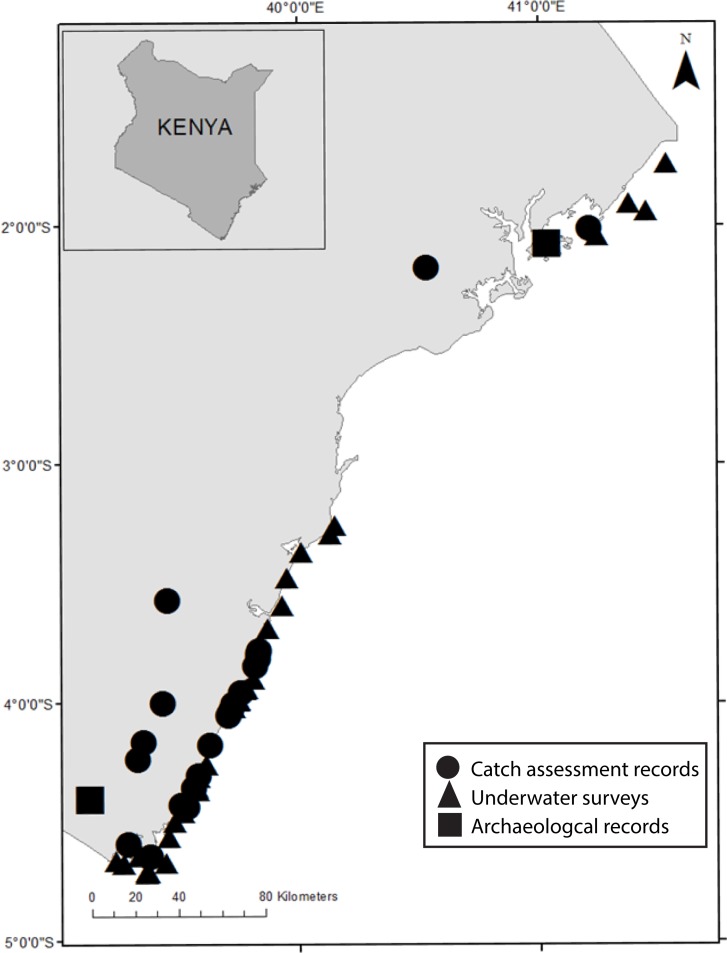
Map of Kenya showing the locations of various data sources for reef fish species occurrences through time.